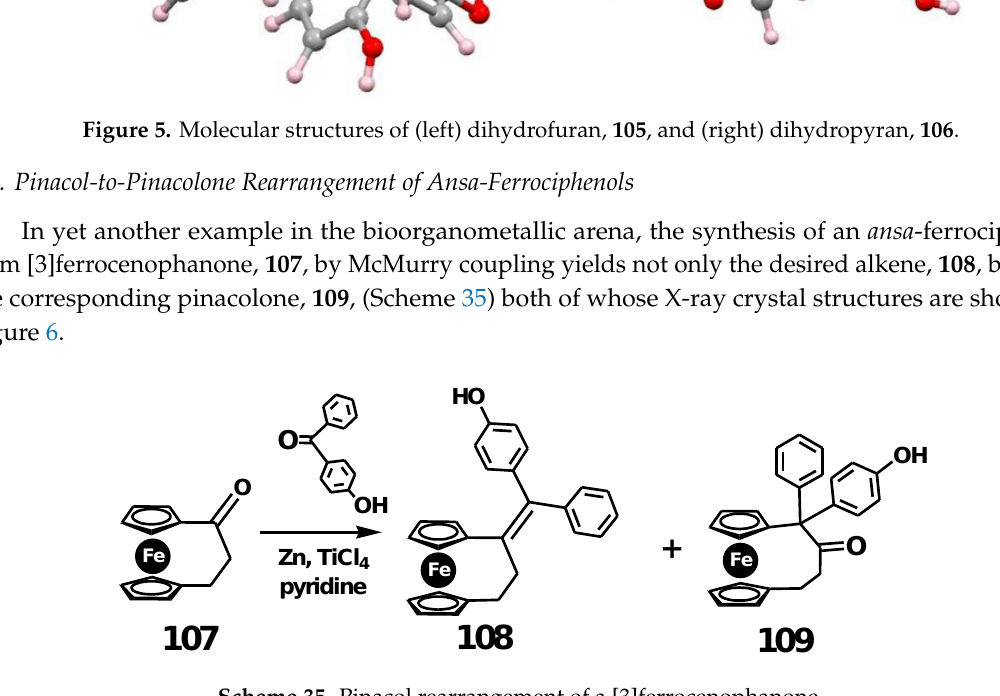
Figure 6. Molecular structures of the ansa -ferrociphenol, 108 , and the pinacolone, 109 . In this case, there are two possible pinacolones: one derived by cation formation adjacent to the ferrocenyl group, as in 110 , the other at the doubly-benzylic position, 111 , as illustrated in Scheme 36. In the event it is the latter that succeeds, it is presumably to relieve the ring strain in the three-carbon bridge thereby forming the pinacolone possessing a four-carbon link between the cyclopentadienyl rings [69]. Moreover, in this strained system, the potential carbocation, 110 , adjacent to ferrocene, is unable to enhance its stability by bending towards the metal. O FeFe 111 110 Ar Ar Fe Ar